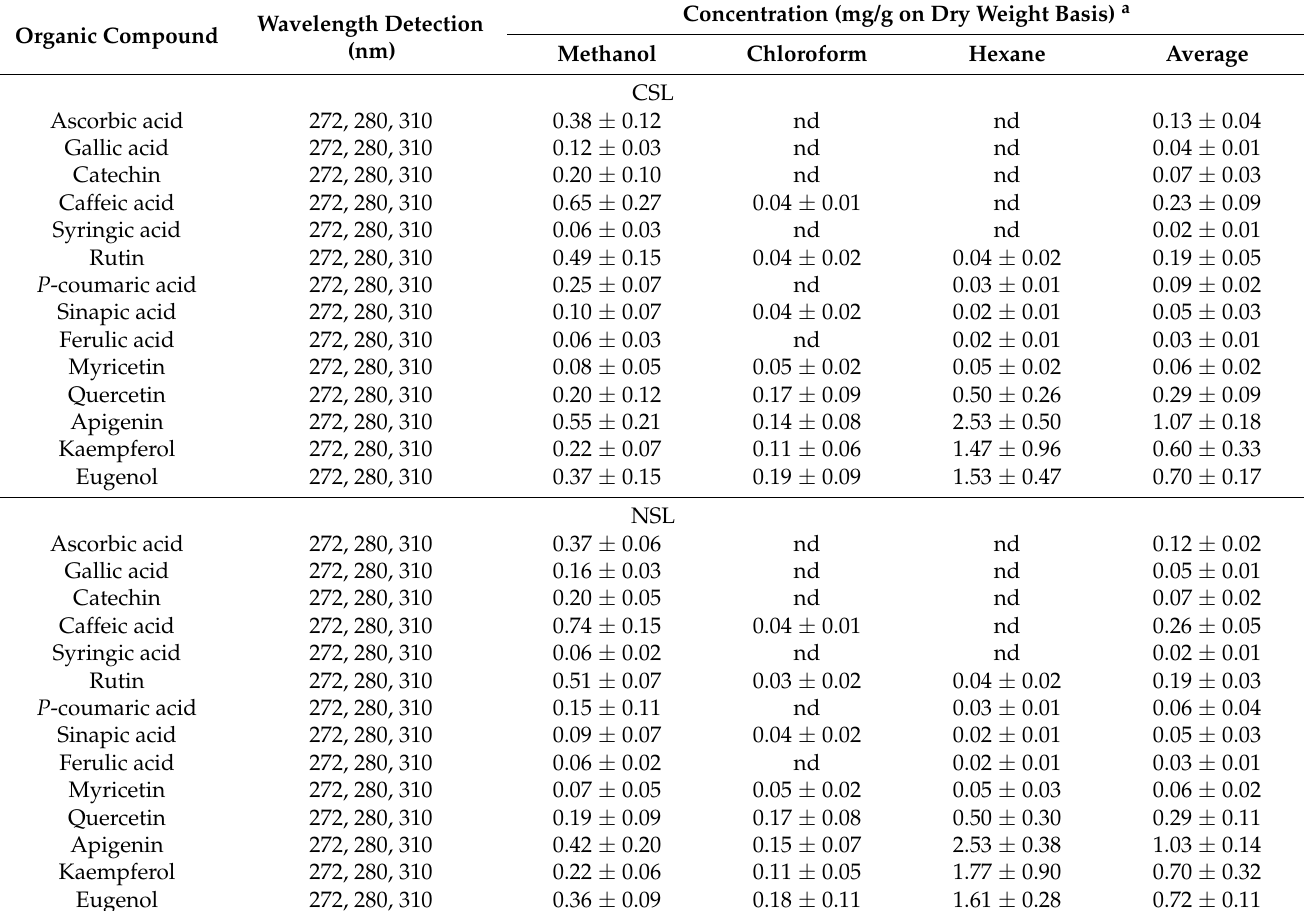
Table 3. Identification and quantification of fourteen synergistic compounds in a variety of solvent extracts of commercial P. sarmentosum leaves (CSL) and non-commercial P. sarmentosum leaves